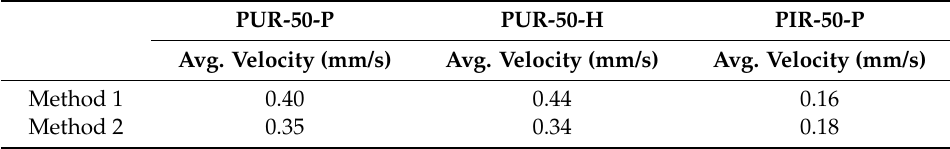
Table 8. Average pyrolysis front velocities of PUR-50-P, PUR-50-H, and PIR-50-P.